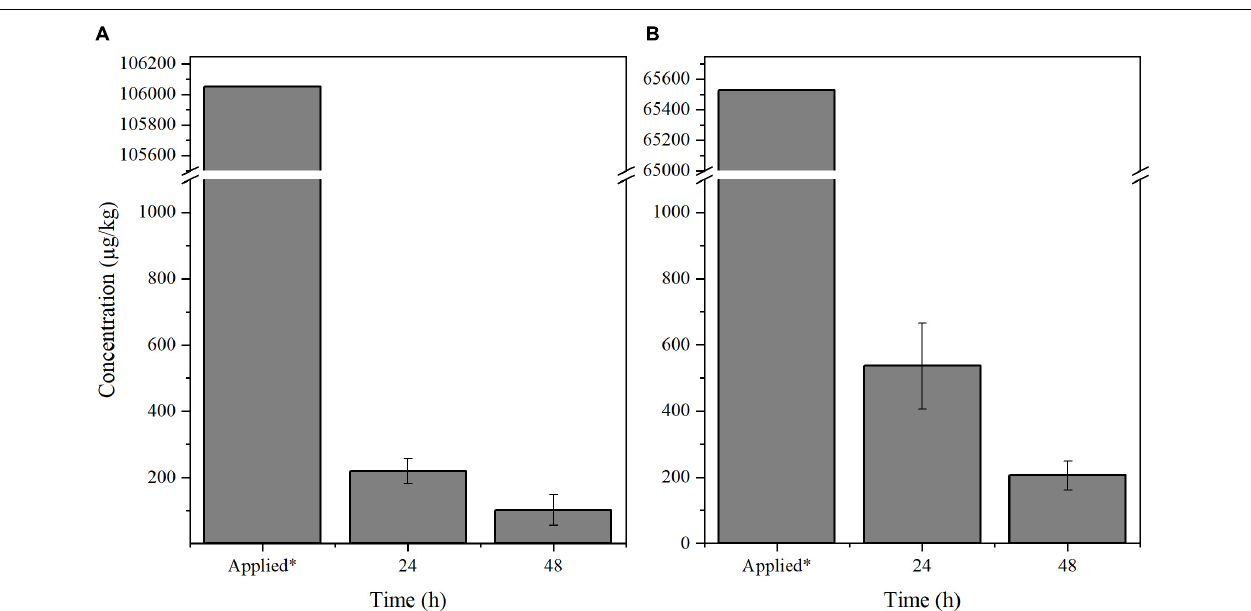
FIGURE 2 | Quantification of (A) benzbromarone and (B) tolfenamic acid from citrus tissue. Leaf samples were collected from 2-year-old Citrus sinensis trees ( n = 3) sprayed with benzbromarone and tolfenamic acid, respectively. The concentration of both compounds were determined using the described LC-MS/MS method 24 and 48 h post-spray. *Concentration of the chemicals applied to